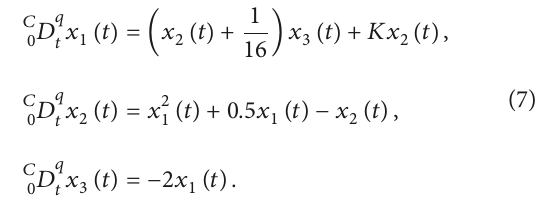
Figure 2: The maximum Lyapunov exponent (MAXLE) varies as fractional-order 𝑞